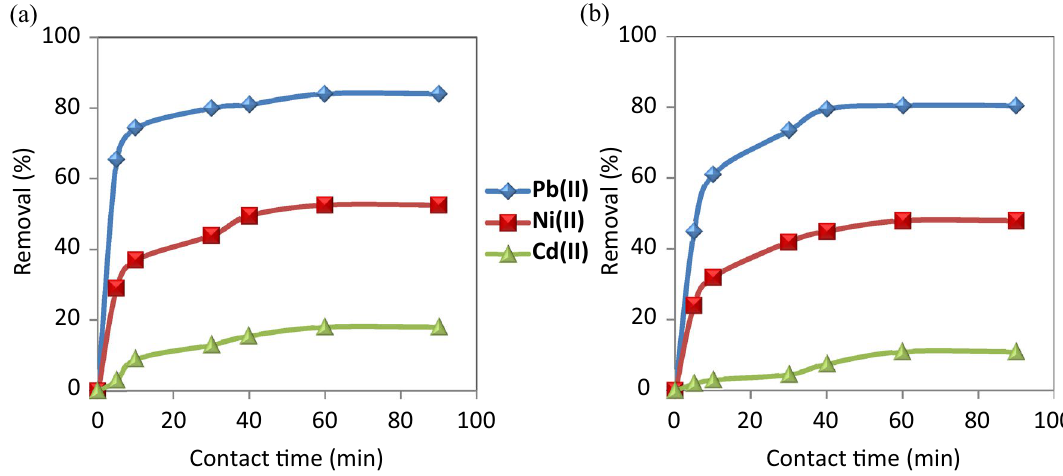
Figure 5. Effect of contact time on the removal of the studied metal ions using ( a ) CuO NPs-1 and ( b ) CuO NPs-2 at initial concentration: 20 mg L −1 , pH: 6, and dose: 0.33 g L −1 . (b)(a)